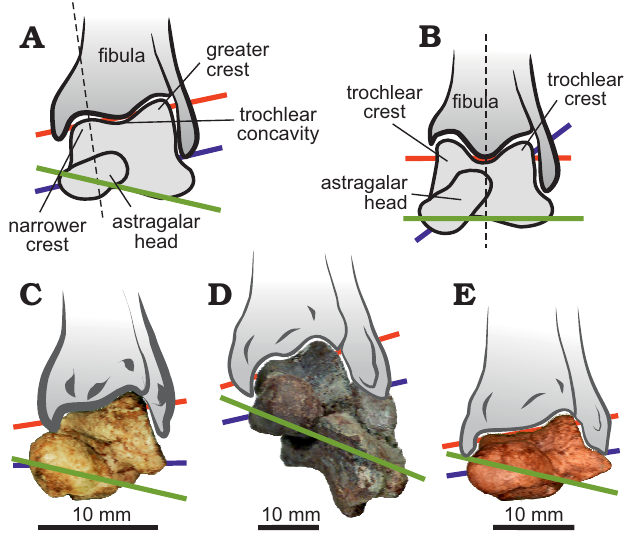
Fig. 6. Illustration of the foot rotation in typotherian notoungulates. Sche- matic anterior view of the ankle of a plantigrade ( A ) and digitigrade ( B ) mammal. Colbertia lumbrerense PVL 6227 ( C ), Typotheria indet. PVL 4292 ( D ), and “ Campanorco inauguralis ” IBIGEO-P 105 ( E ) in anterior view. The colored lines represent the hypothetical tibia long axis (black line), mediolateral axis of the astragalar head (blue line), the plane of the trochlear crests (red line), and the hypothetical metatarsal plane (green